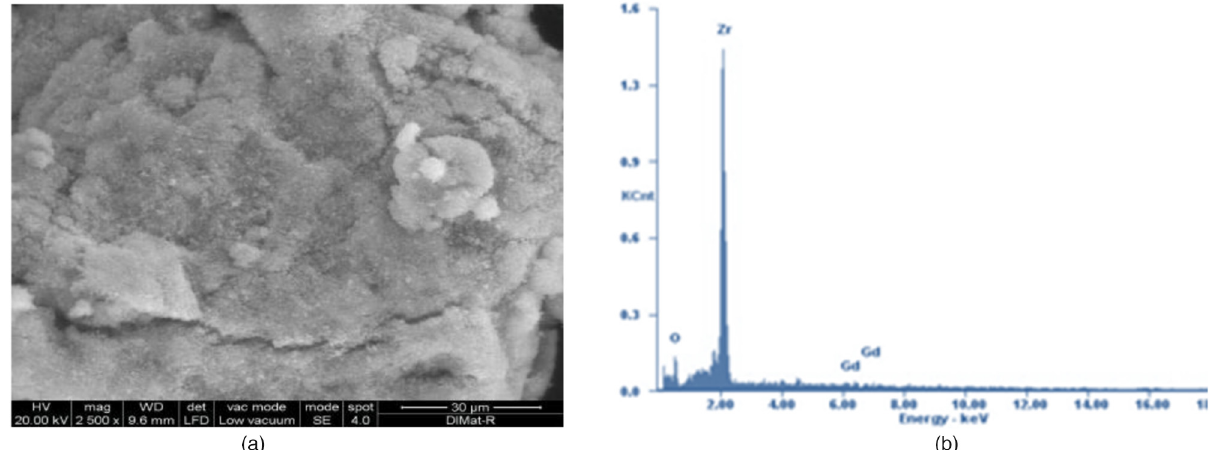
Fig. 3. (a) SEM micrograph of nano-SPVD powders of ZrO 2 doped with Gd. (b) EDX spectrum of nano-SPVD powders of ZrO 2 doped with Gd. Table 2. Experimental results from characterization of oxide nanoparticles.